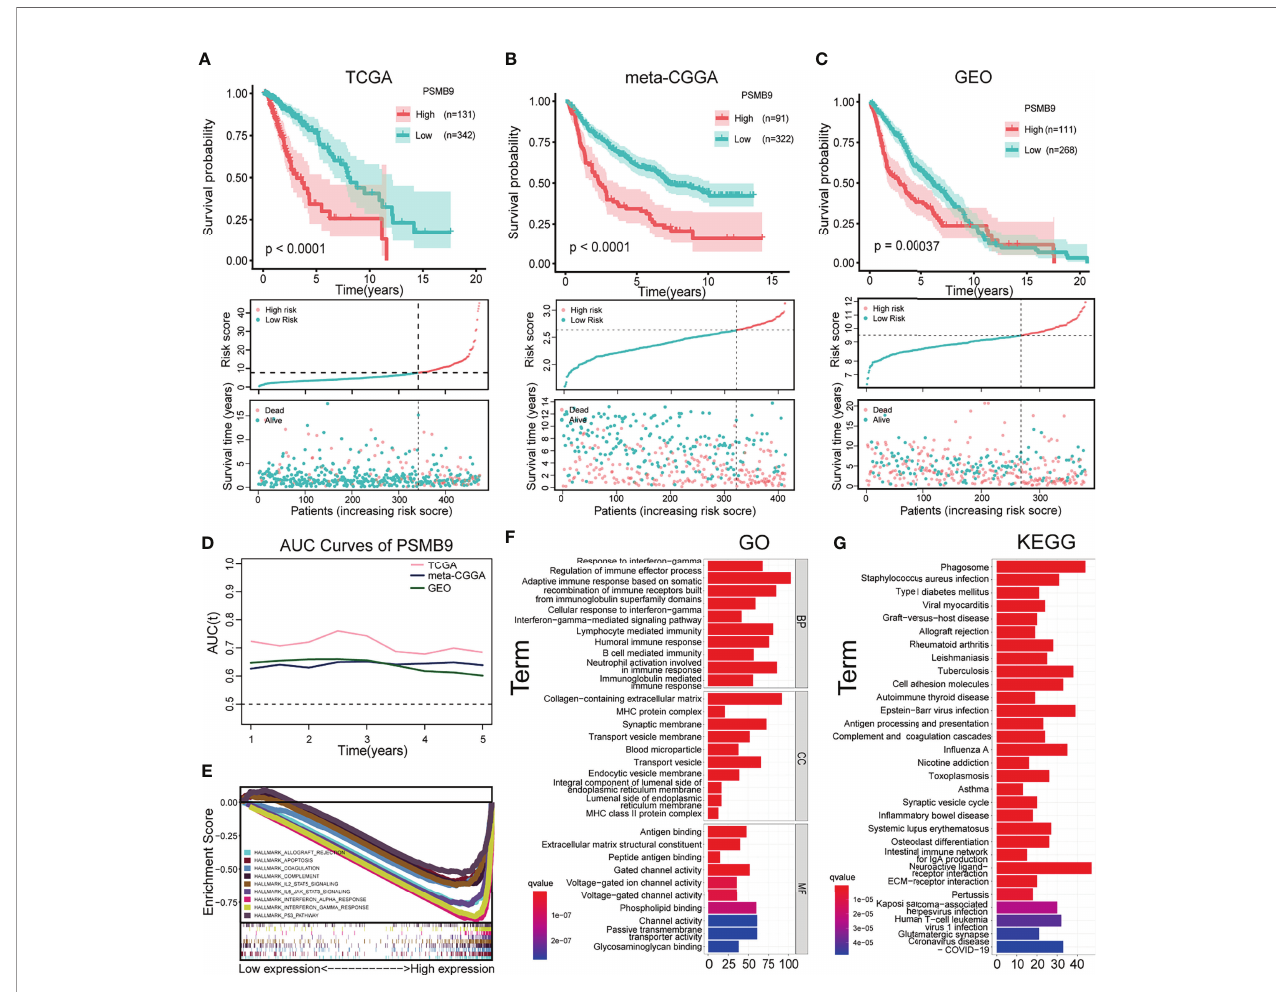
FIGURE 4 | Survival analysis and enrichment analysis. (A – C) K-M survival analysis was performed to validate that shorter survival and poorer prognosis in LGG patients with high PSMB9 expression in three databases (TCGA (A) , CGGA (B) and GEO (C) ). (D) AUC curve values were all above 0.6, indicating that the predictive power of PSMB9 was stable (E) Multi-enrichment analysis of PSMB9 related DEGs. (F) Gene Ontology analysis of PSMB9-related DEGs. (G) Kyoto Encyclopedia of Genes and Genomes pathway analysis of PSMB9 related